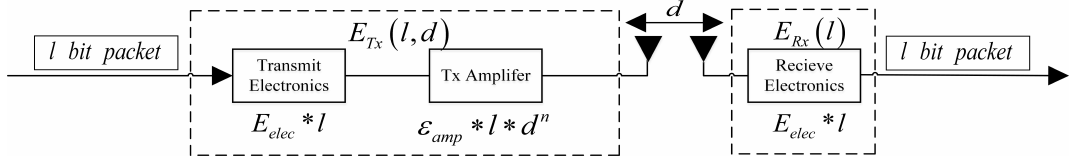
Figure 1. Radio energy dissipation